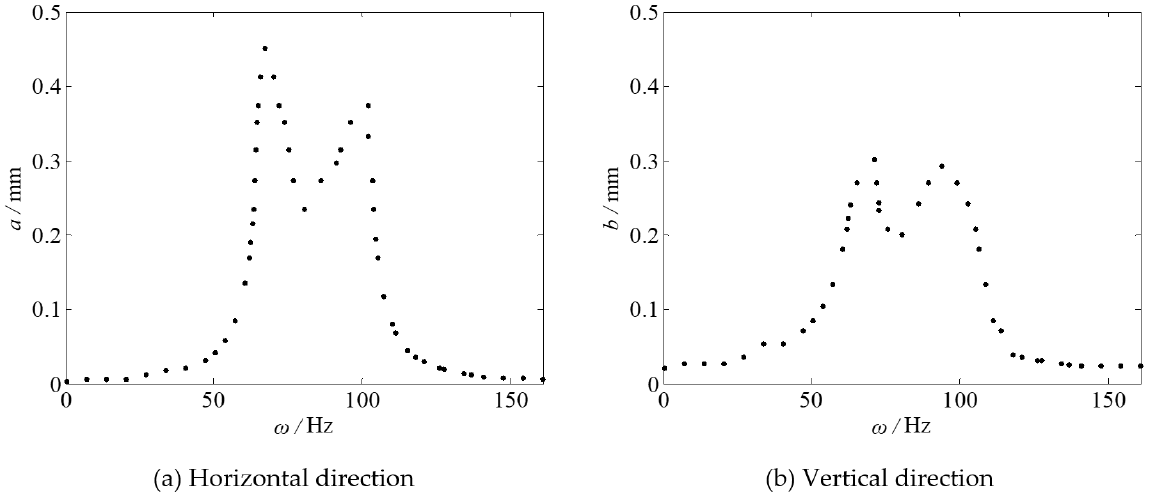
Figure 15. Amplitude–frequency curve of the coupled vibration system of hot rolling mill rolls with piecewise nonlinear friction force coefficient β = 5. ( a ) Amplitude–frequency curve of horizontal direction; ( b ) Amplitude–frequency curve of vertical direction.